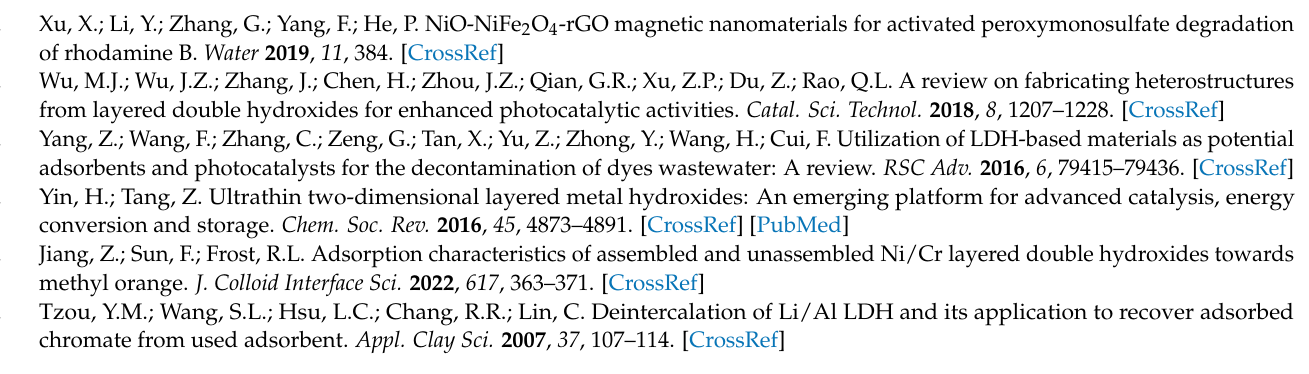
Figure S2: SEM image of (a) Ni/Cr(2/1)-1.0LA LDH and (b) Ni/Cr(2/1) LDH; Figure S3: